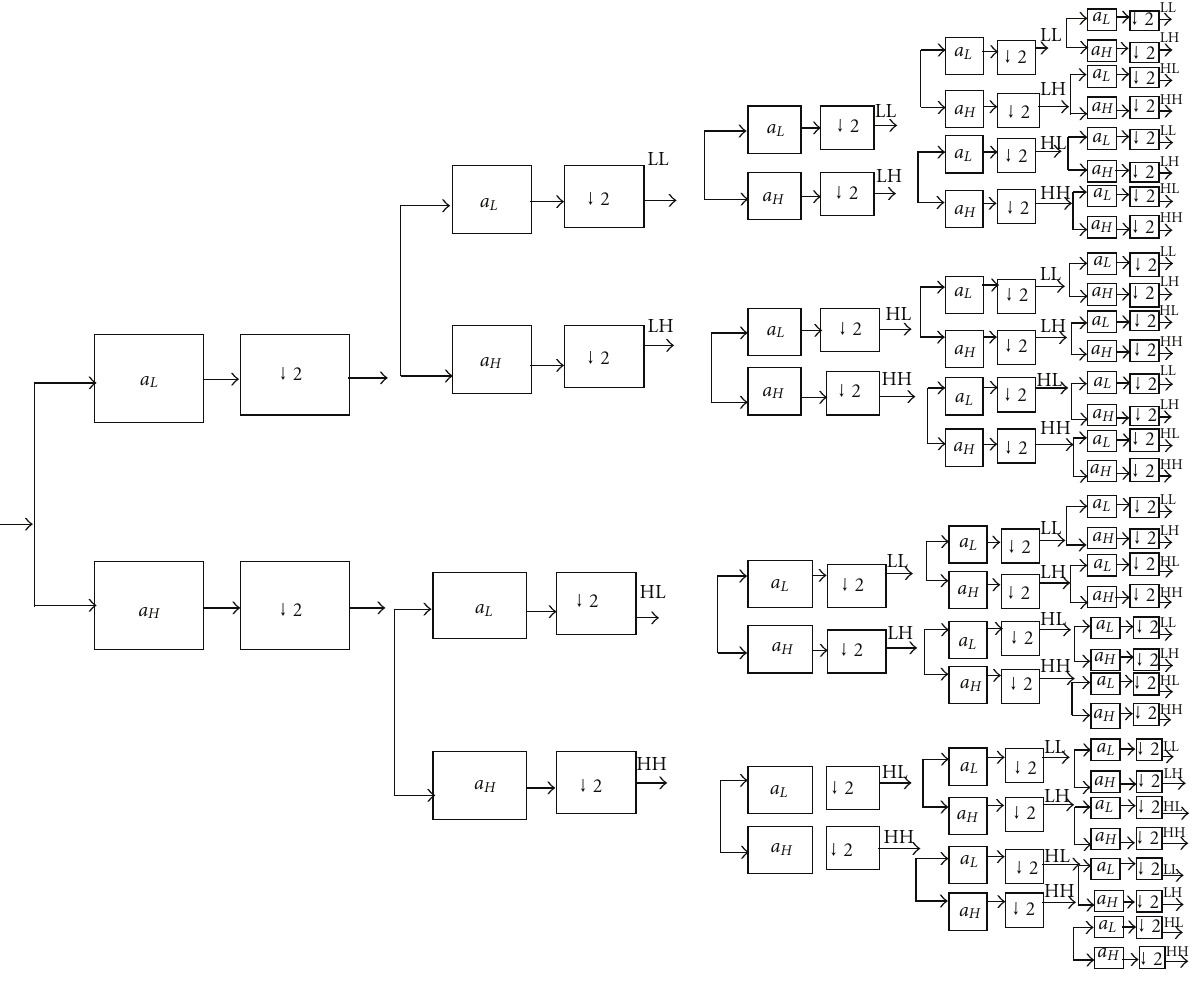
Figure 10: Example of five-level in wavelet transform.